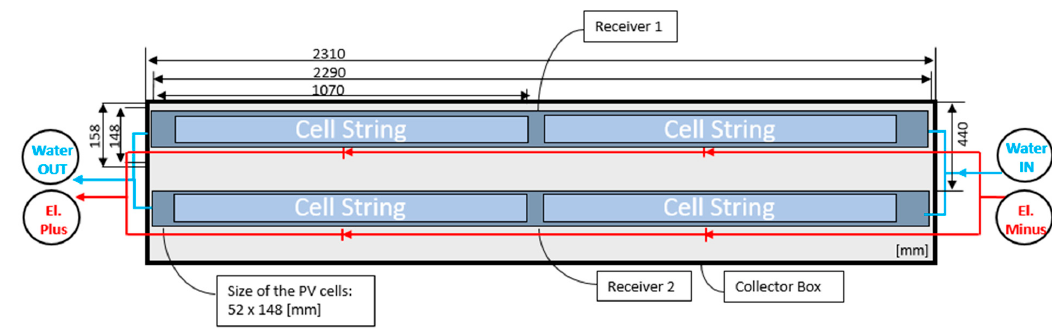
Figure 2. Top view of the concentrated photovoltaic-thermal collector (CPVT) collector. The water connections are marked in blue and the electrical connections in red [20].